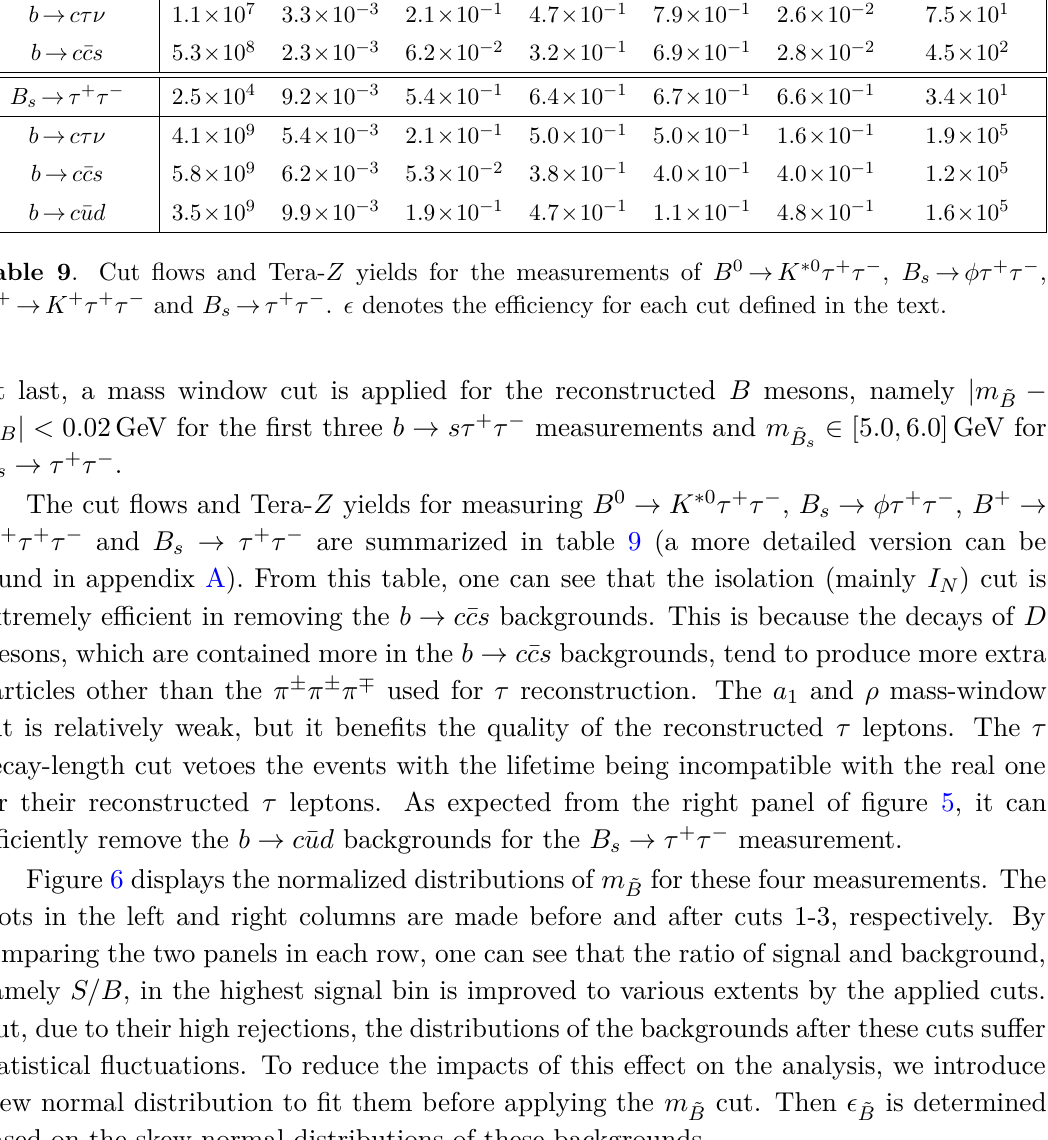
Table 9 . Cut flows and Tera- Z yields for the measurements of B 0 → K ∗ 0 τ + τ − , B s → φτ + τ − , B + → K + τ + τ − and B s → τ + τ − . (cid:15) denotes the efficiency for each cut defined in the text.